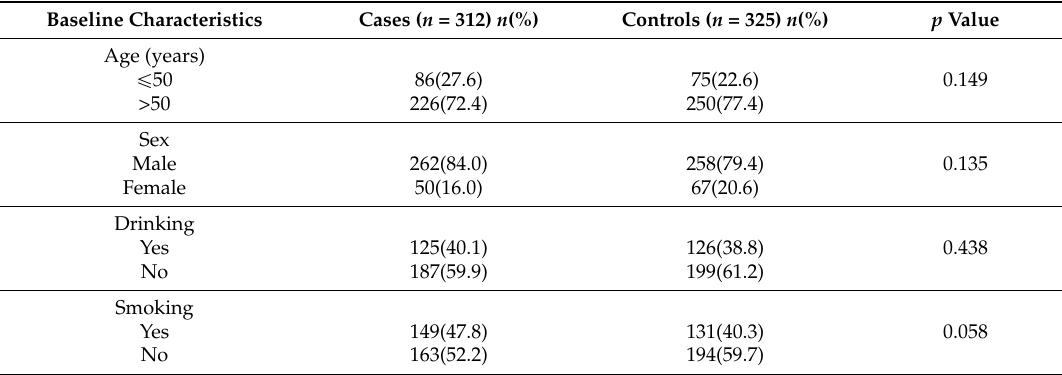
Table 1. Baseline characteristics of participants stratified by case-control